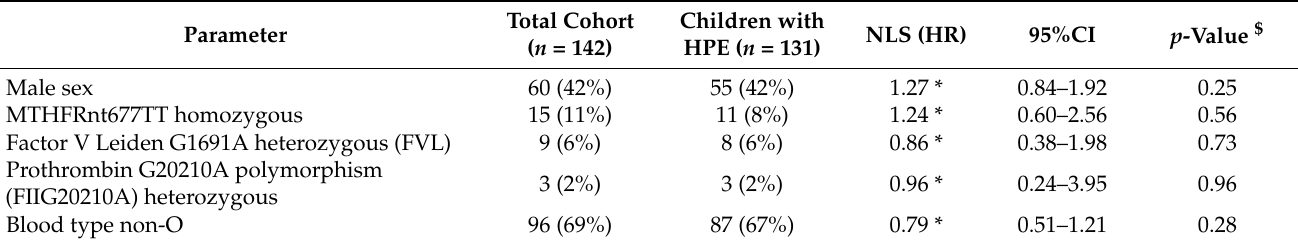
Table 2. Occurrence of thrombophilic factors in the study group.